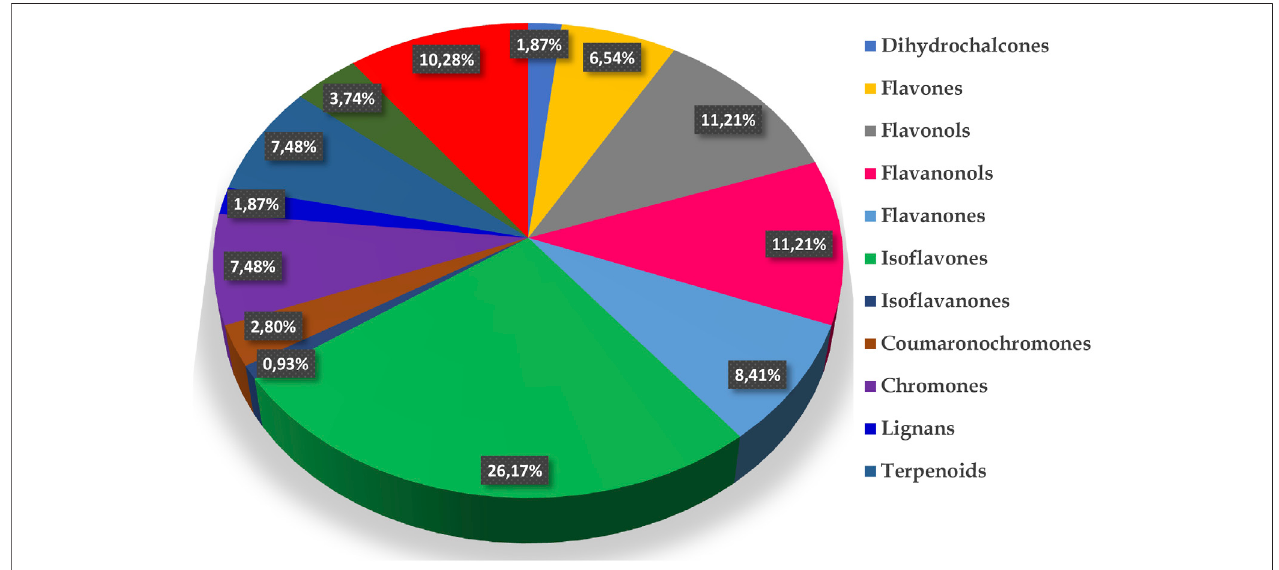
FIGURE 3 | Chemical diversity of Eriosema